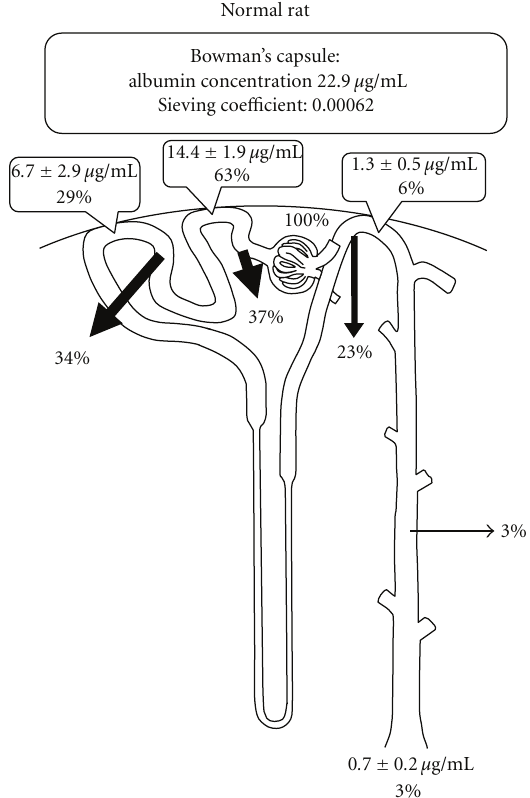
Figure 1: Albumin concentration along the nephron calculated from the data from a rat fractional micropuncture study